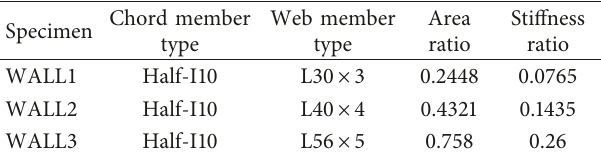
Figure 13: Multilevel three-dimensional finite element shear wall model with steel truss CBs. Table 5: Specimen details of steel truss CB shear wall